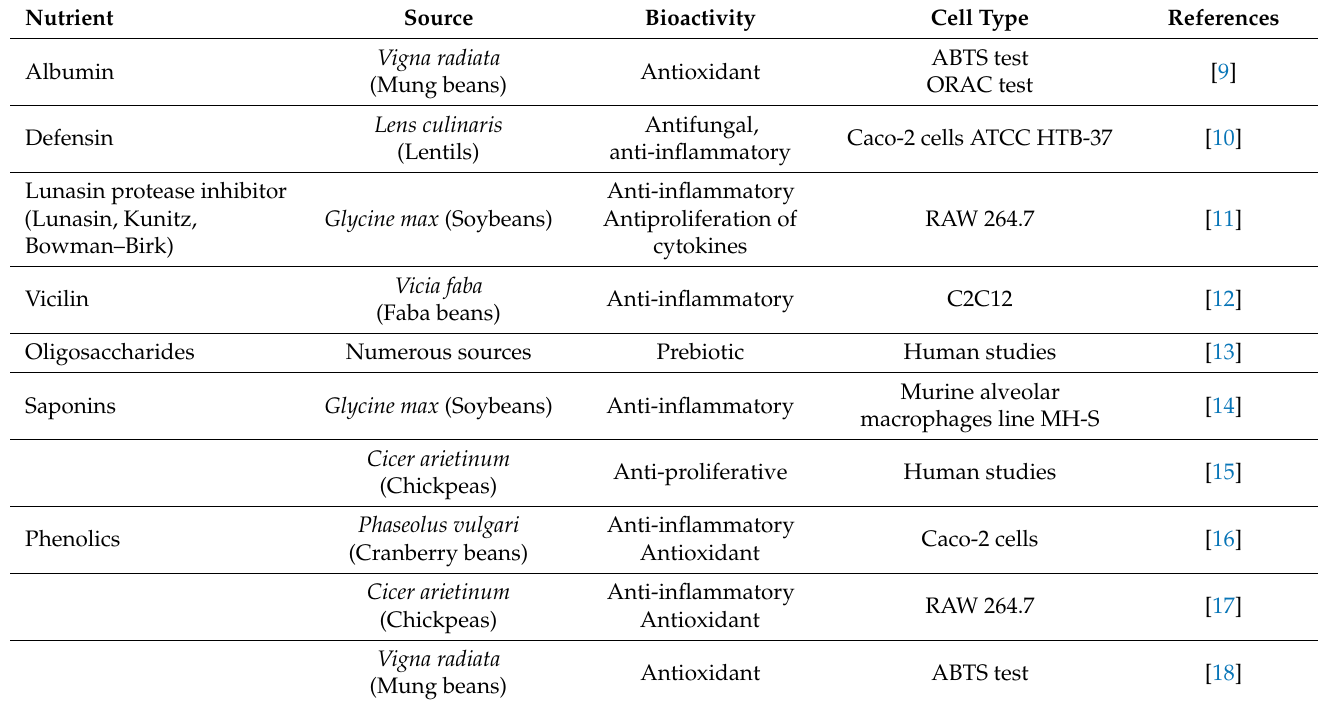
Table 1. Key bioactives from aqueous extracts of Leguminosae and their mechanism of